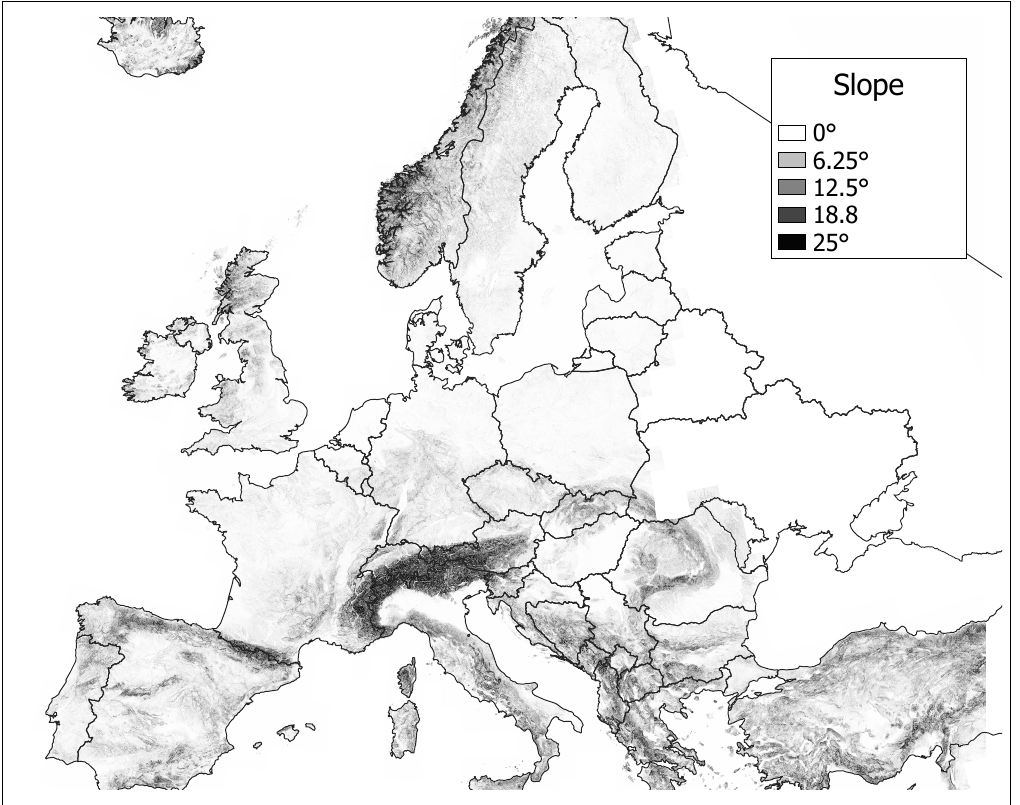
Figure 3. Geographical coverage of slope data in Europe. Own illustration based on